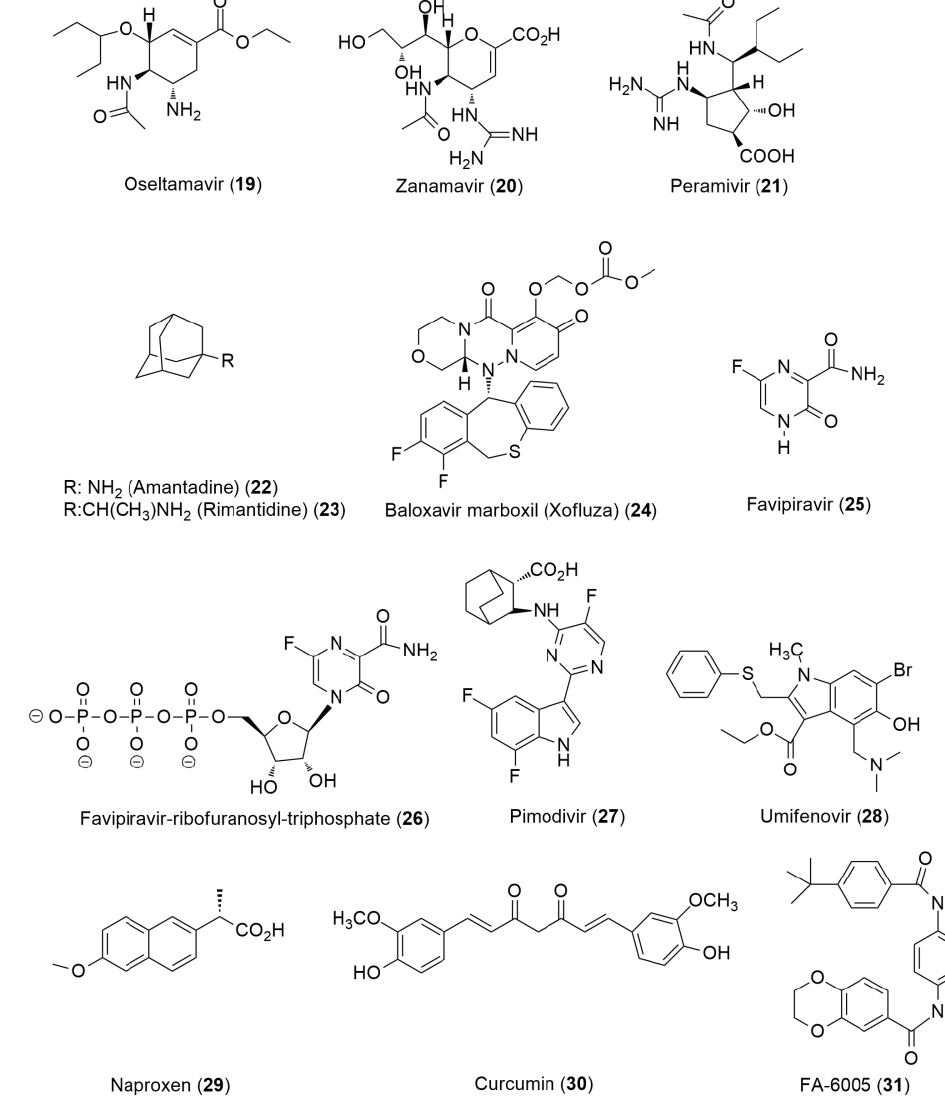
Figure 8. Direct-acting anti-influenza agents.